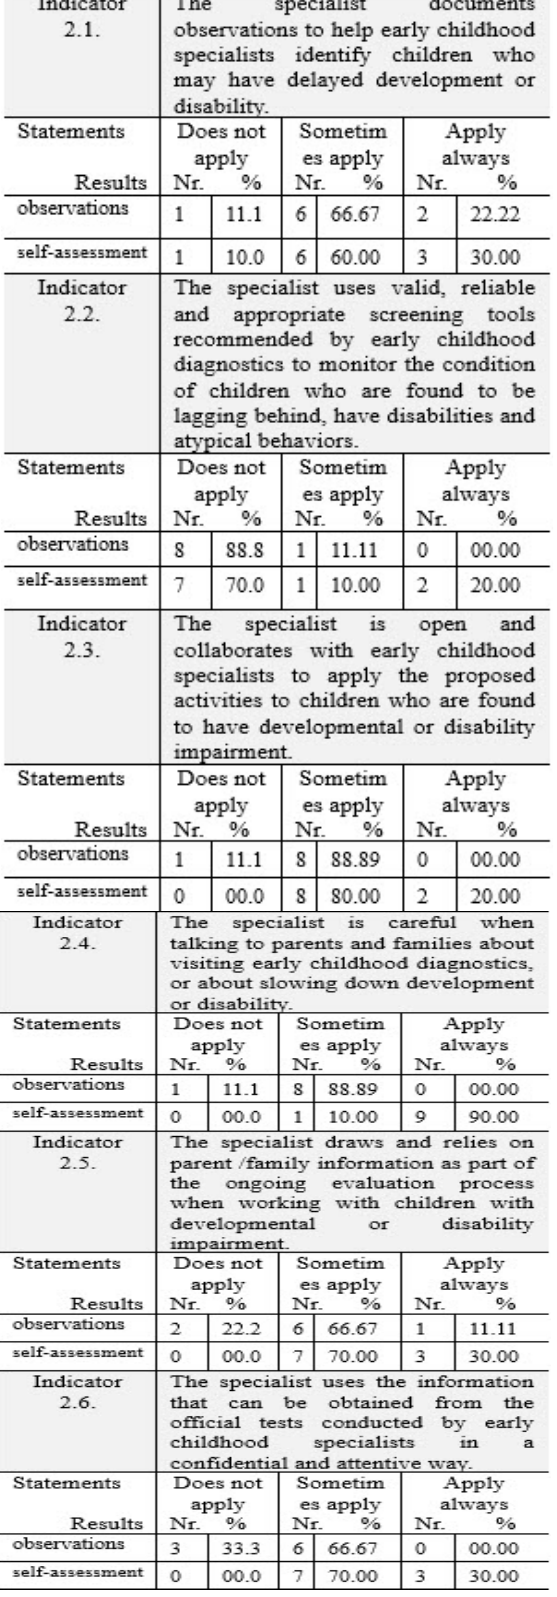
Table 34. Principle 2: Consultation with an Early Child Diagnostic Specialist for for - mal screening and assessment where neces - sary prevents multiple developmental delays and atypical behaviors later in